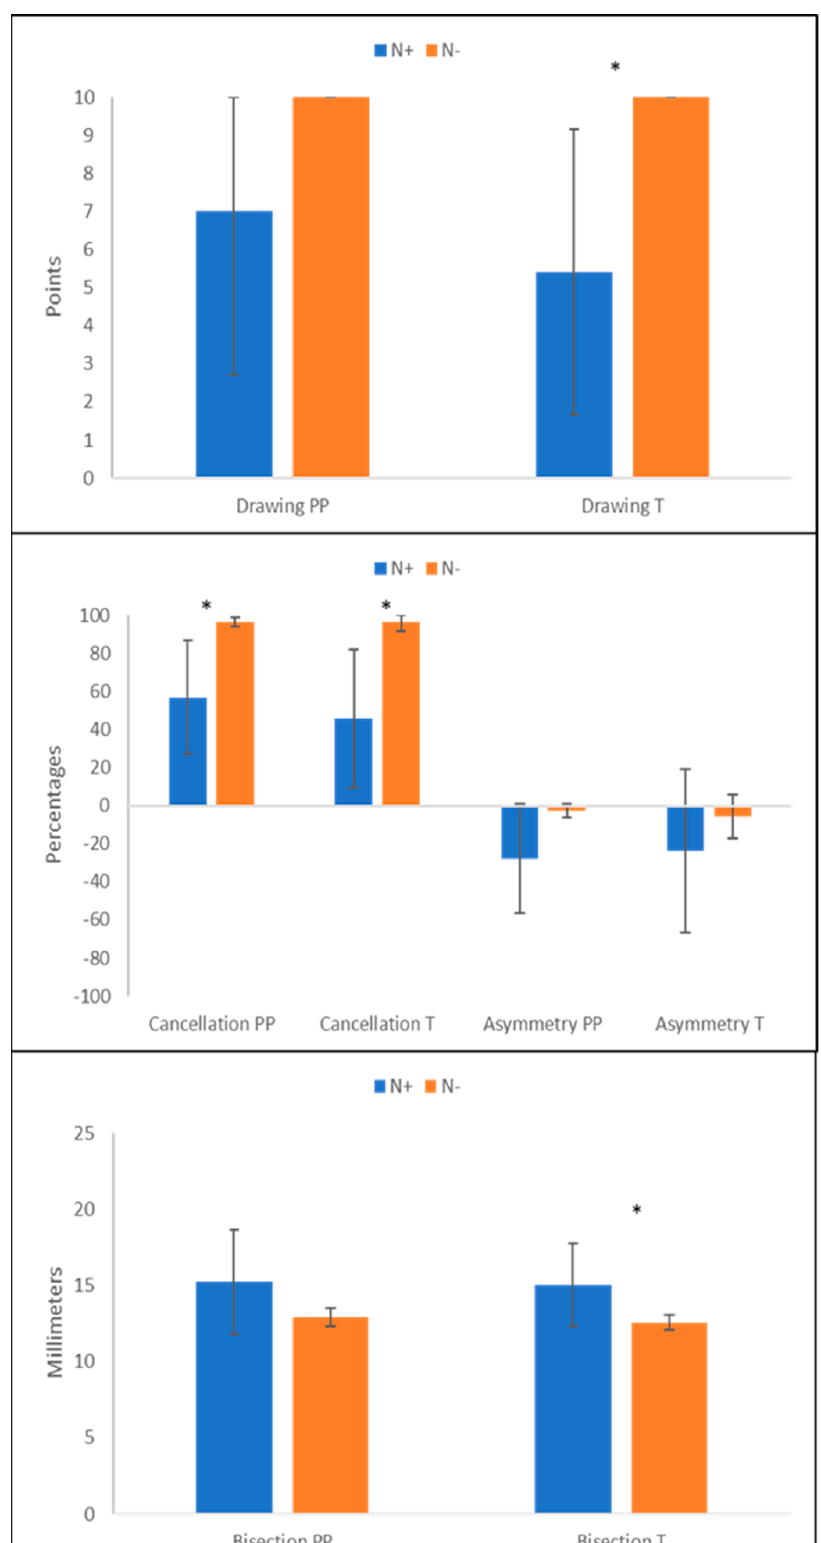
Figure 4. Mean performance scores for N+ and N_ patients at the paper-and-pencil (PP) and computerized (T) tests. Error bars represent ± 1 SD. Asterisks represent signi fi cant di ff erences.